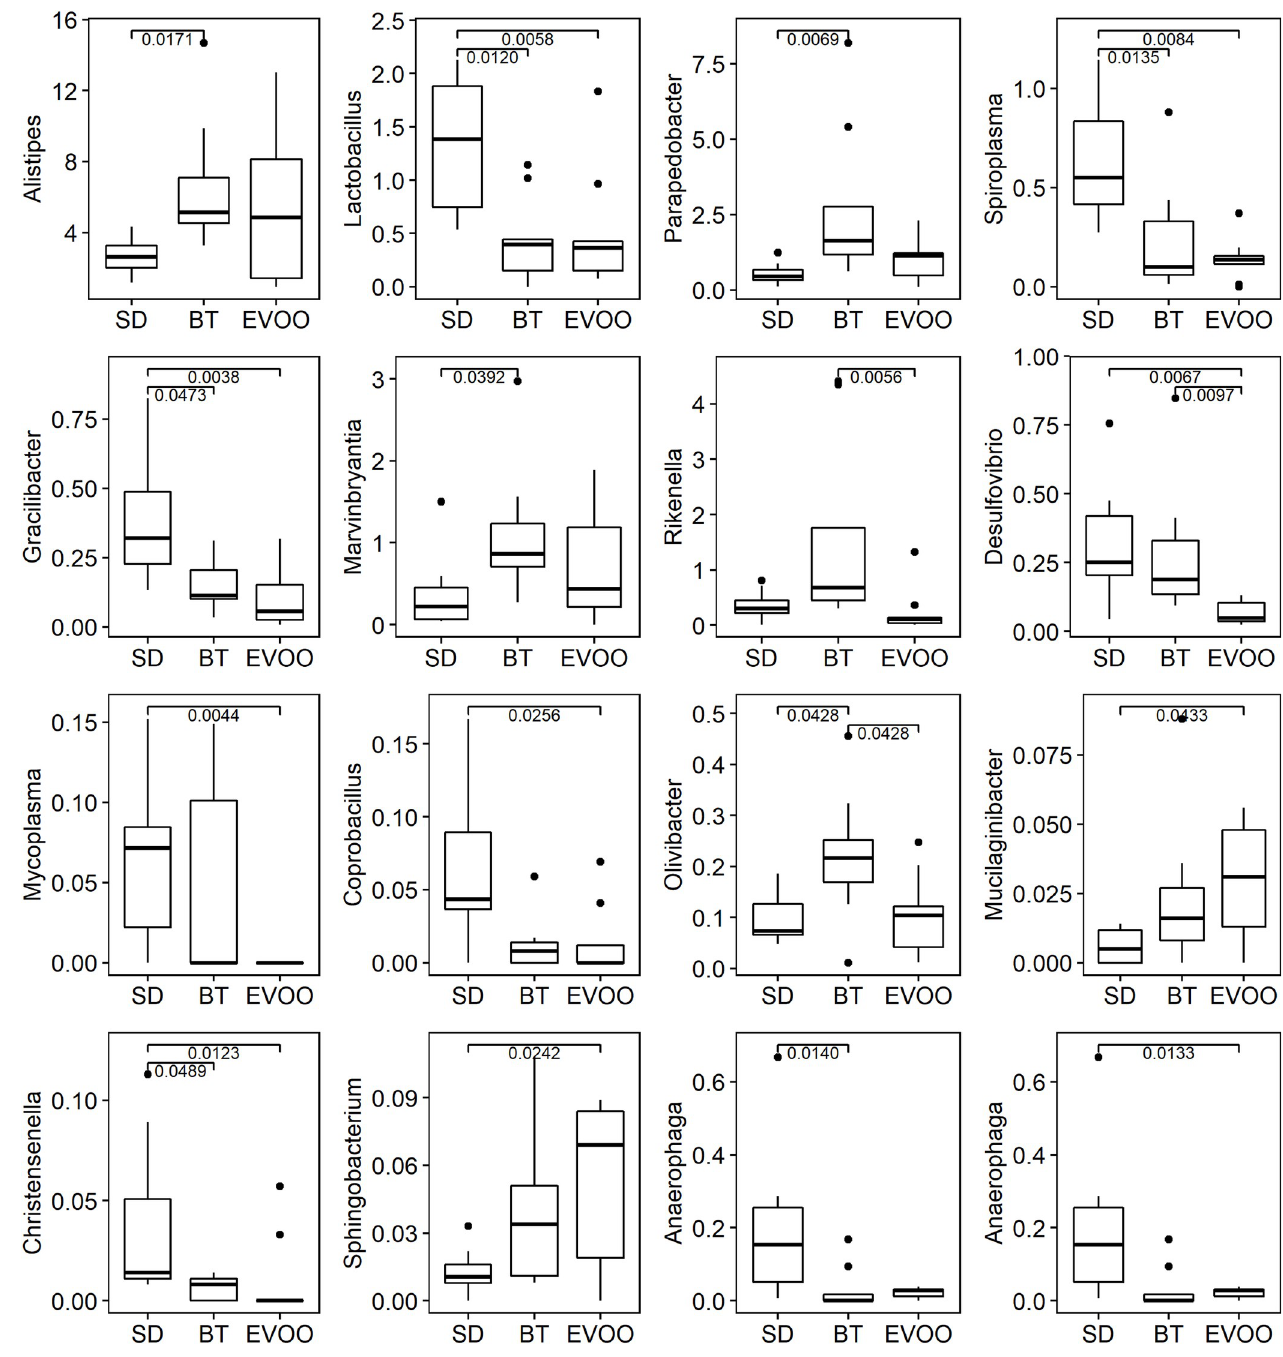
Fig 4. Box-plot representation of the percentage distribution of the sixteen genera with significant differences (p < 0.05) among mice fed a diet enriched with butter (BT), virgin olive oil (EVOO) or standard chow (SD).